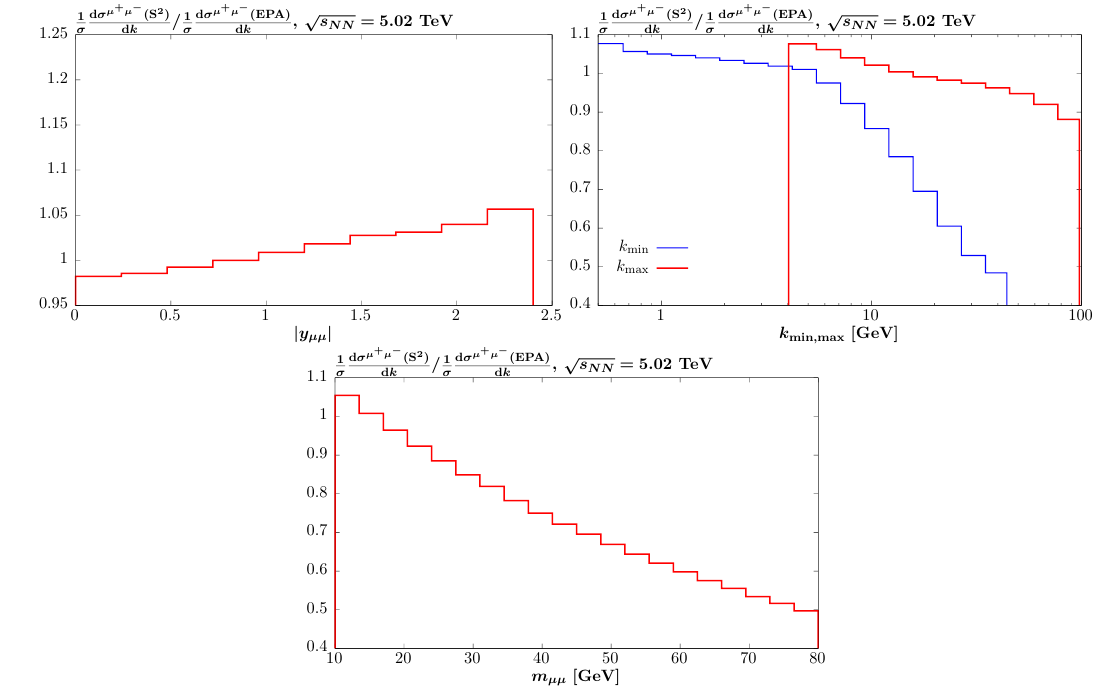
Figure 3: Normalized differential cross sections as a function of the (top left) dimuon rapidity, (top right) maximum photon energy ( k ( k ), and (bottom) dimuon invariant mass, calculated using a modified version of min SuperChic 4 [ 1 ] . The ratio of the full result including the survival factor to the EPA result, i.e. excluding this, is shown; in both cases no b We emphasise that in the corresponding absolute distributions the results including survival effects will be suppressed with respect to the pure